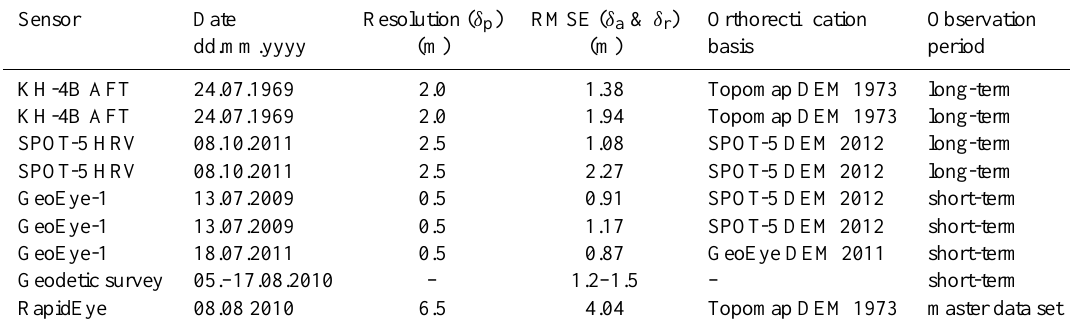
Table 2. List of remote sensing and field data used for determination of thermo-erosion along the west coast of the Buor Khaya Peninsula and corresponding